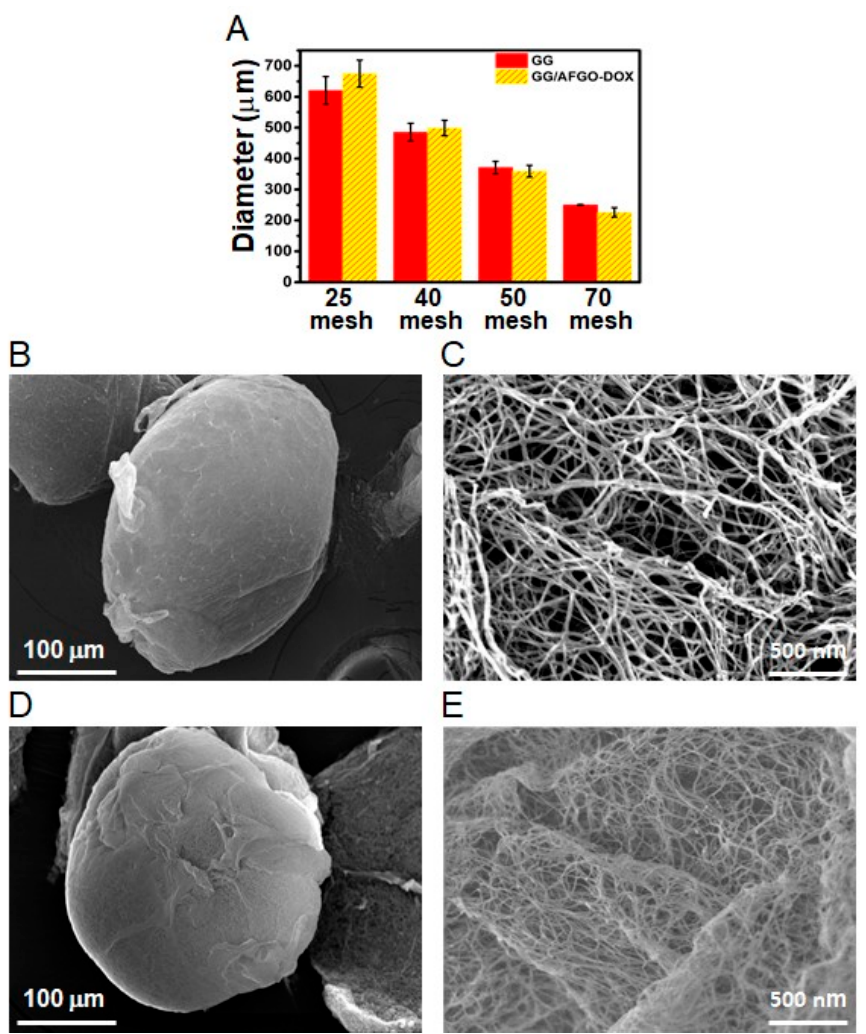
Figure 3. ( A ) Size distribution of GG and GG/AFGO–Dox following separation using 25, 40, 50, and 70 mesh sieves, and their evaluation using a laser diffraction particle size analyzer. SEM images of GG ( B ) surface and ( C ) inner microsphere. SEM images of GG/AFGO–DOX ( D ) surface and ( E ) inner microsphere.